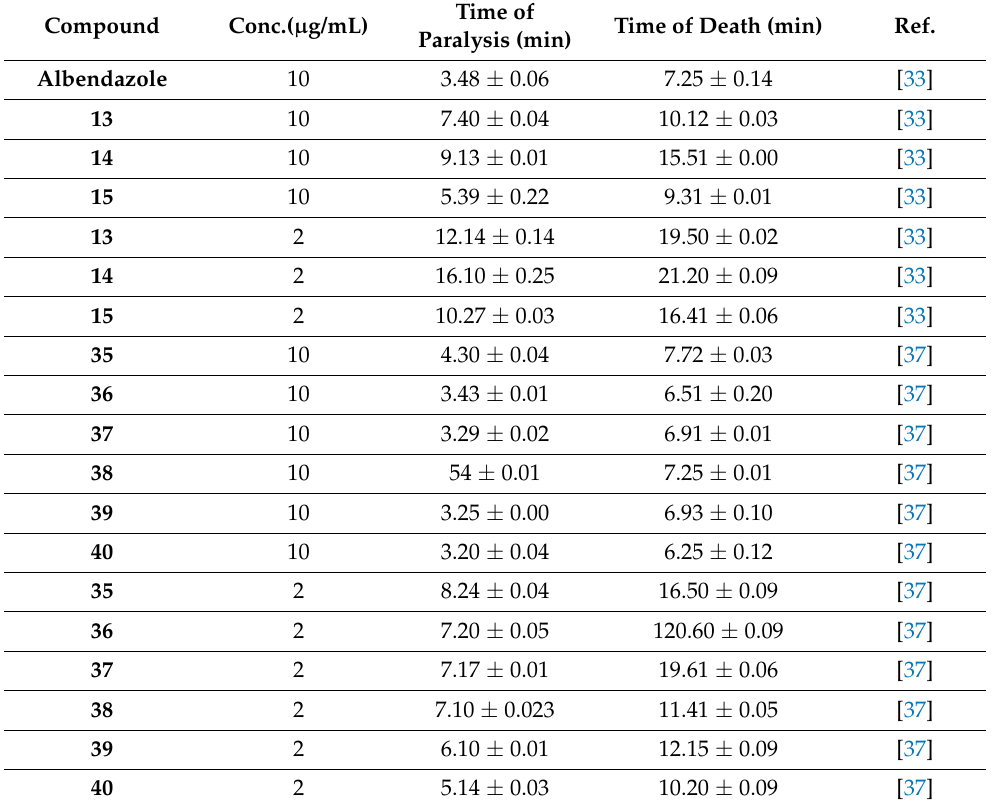
Table 4. Anthelmintic activity of the coumarin-derived imine–metal